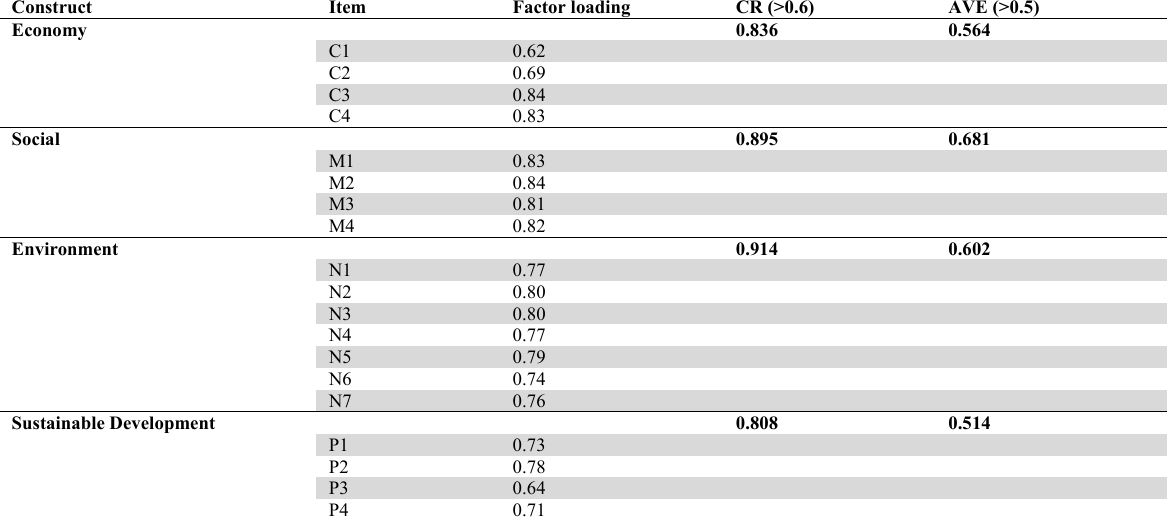
The Composite reliability (CR) and Average Variance Extracted (AVE)